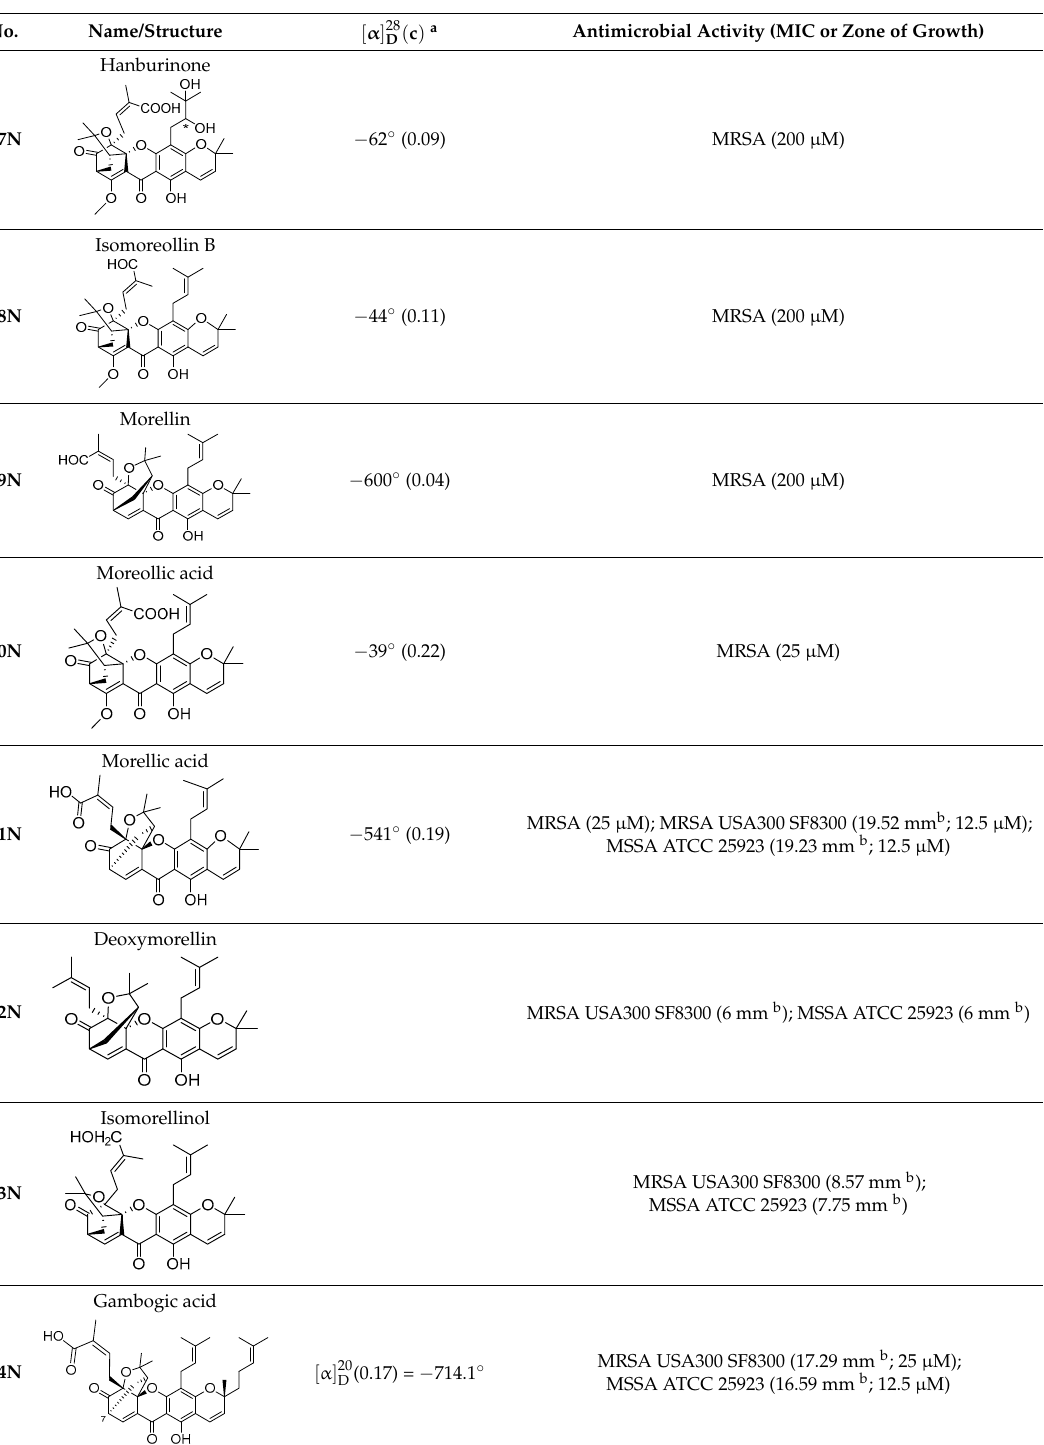
Table 5. Antimicrobial activity of natural caged xanthones with pyran group.